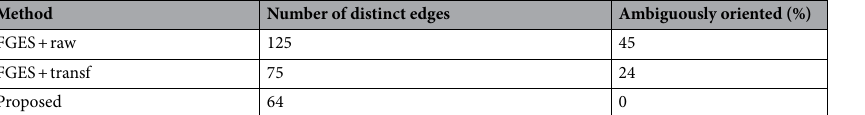
Table 2. Directional stability. The table shows the number of distinct edges that appeared in half of the 1000 bootstrap replications, and the percentage of ambiguously oriented edges.